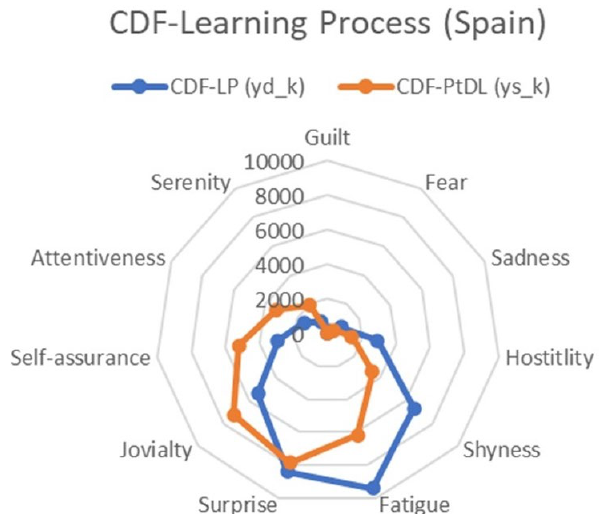
Figure 4. Radar Plot – Configuration Sentiment